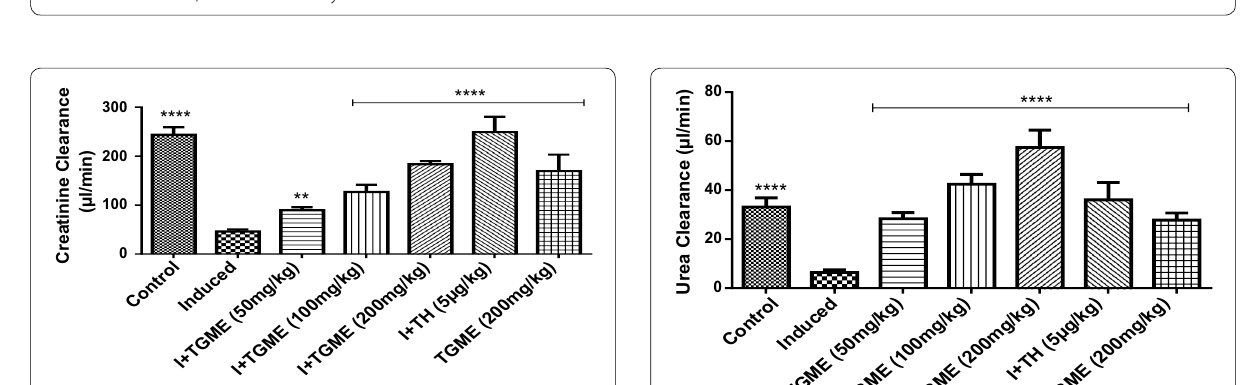
Fig. 5 Effect of aqueous methanolic leaf extract of Triclisia gilletii on creatinine clearance in animals administered ethane-1,2-diol. Fig. 6 Effect of aqueous methanolic leaf extract of Triclisia gilletii Data are expressed as mean SEM of 6 rats ( n 6); ** p < 0.01, ± = on urea clearance in animals administered ethane-1,2-diol. Data are and **** p < 0.0001; *denotes that data were compared with expressed as mean SEM of 6 rats ( n 6); **** p < 0.0001; *denotes ethane-1,2-diol; TGME Triclisia gilletii aqueous methanolic extract, TH ± = that data were compared with ethane-1,2-diol; TGME Triclisia gilletii tamsulosin hydrochloride aqueous methanolic extract, TH tamsulosin